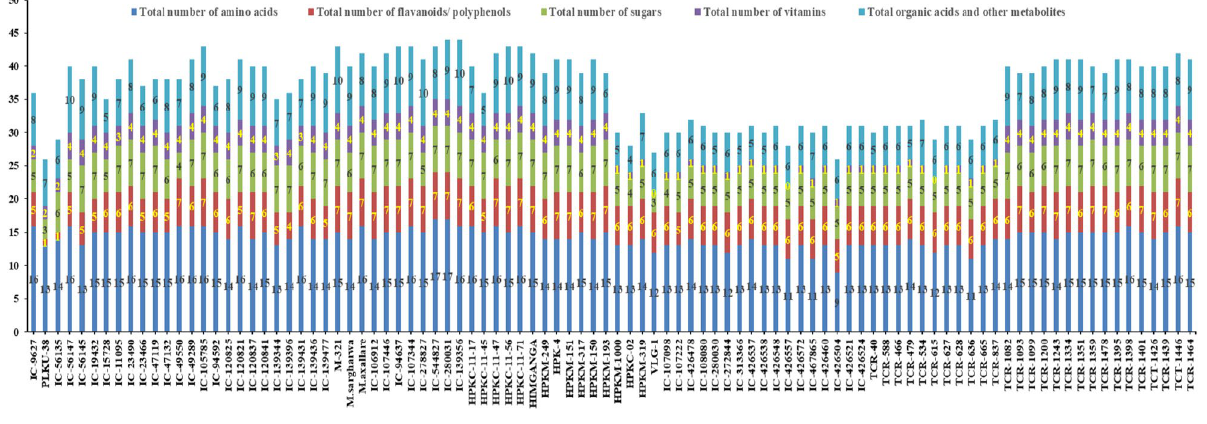
Figure 2. Distribution of different number of identified metabolites (amino acids, flavanoids/polyphenols, sugars, vitamins and organic acids and other metabolites) in the diverse panel of horsegram and δ 5.42 ppm (d) (sucrose/Stachyose), respectively. The other grouped peaks represented the protons of other molecules in the range of δ 3.30–4.10 ppm [(inositiol at δ 3.49 (dd) and maltose at δ 3.88 ppm (dd) (Table SI-2)].